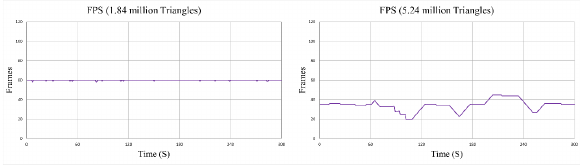
Figure 9. Relation between the number of triangles and rendered FPS.